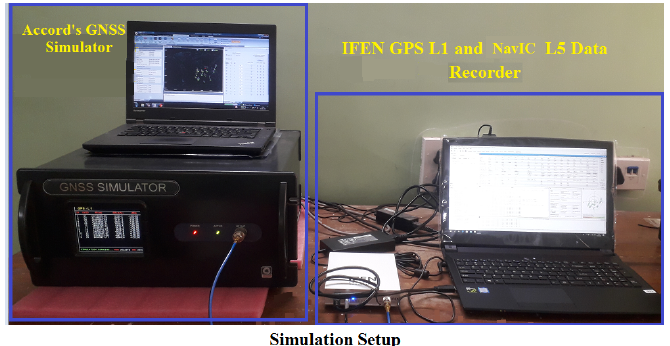
Figure 4. GNSS signal simulation and data collection